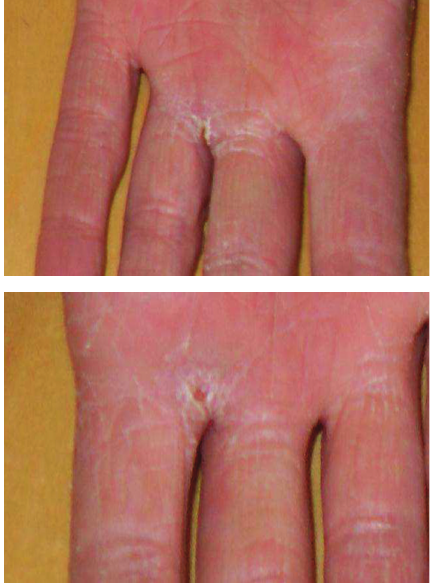
Figure 5: Vasculitic-like ulcerative lesions of the hands